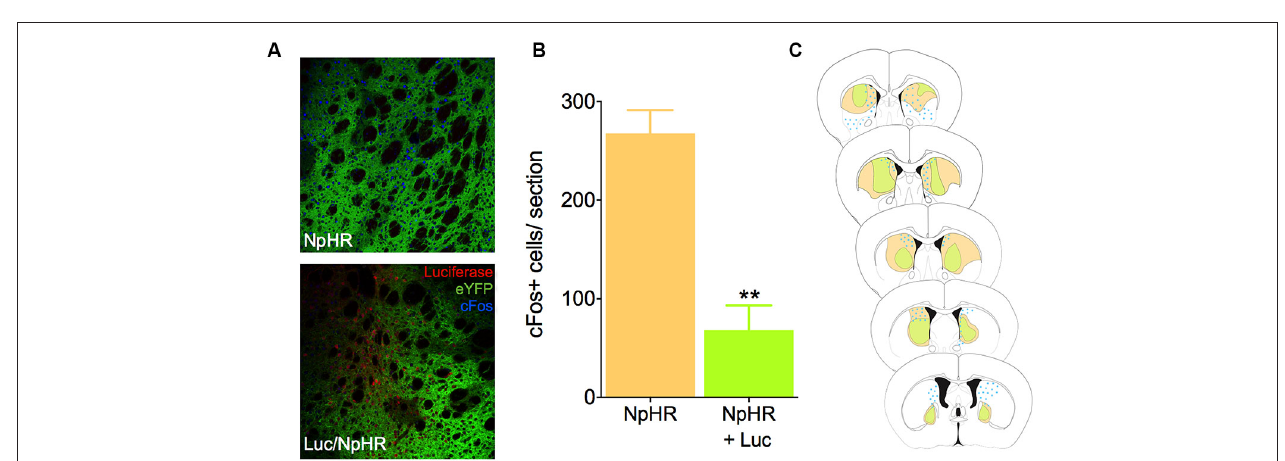
FIGURE 1 | Virally expressed luciferase generates light. (A) Emission and activation spectra for firefly luciferase (green) and halorhodopsin (amber), respectively. Note the high degree of overlap between the two. (B) Schematics of the firefly luciferase viral constructs used. (C) Light output (in